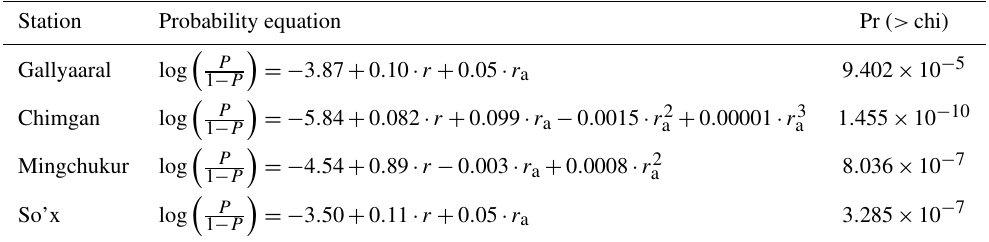
Table 4. Rainfall threshold probability equations of mudflow occurrences in selected areas ( P – probability, r – daily rainfall, r a – antecedent rainfall, Pr ( > chi) – chi-squared results for the